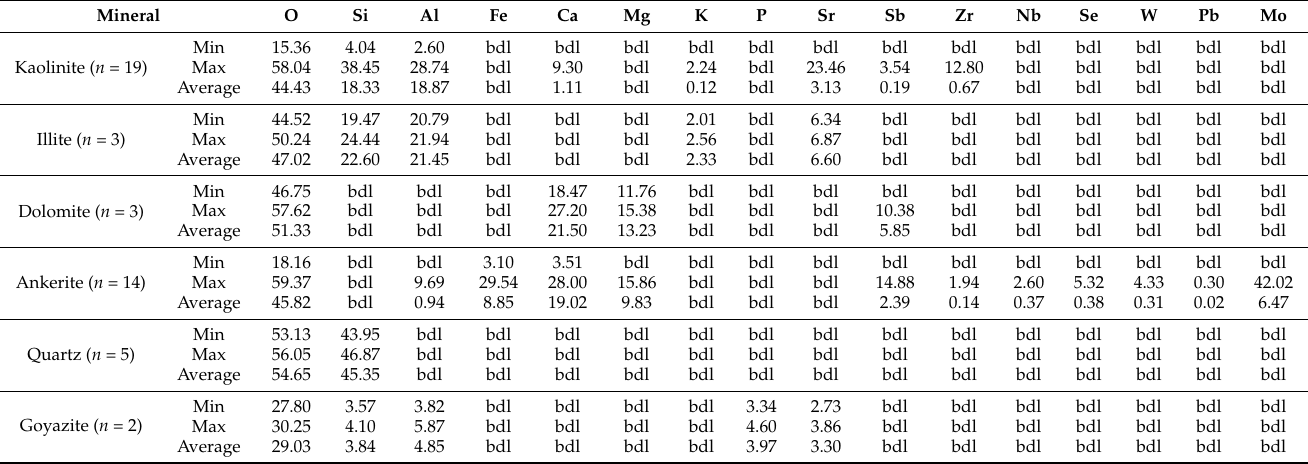
Table 10. SEM-EDS semi-quantitative analysis of some minerals in the Tashan